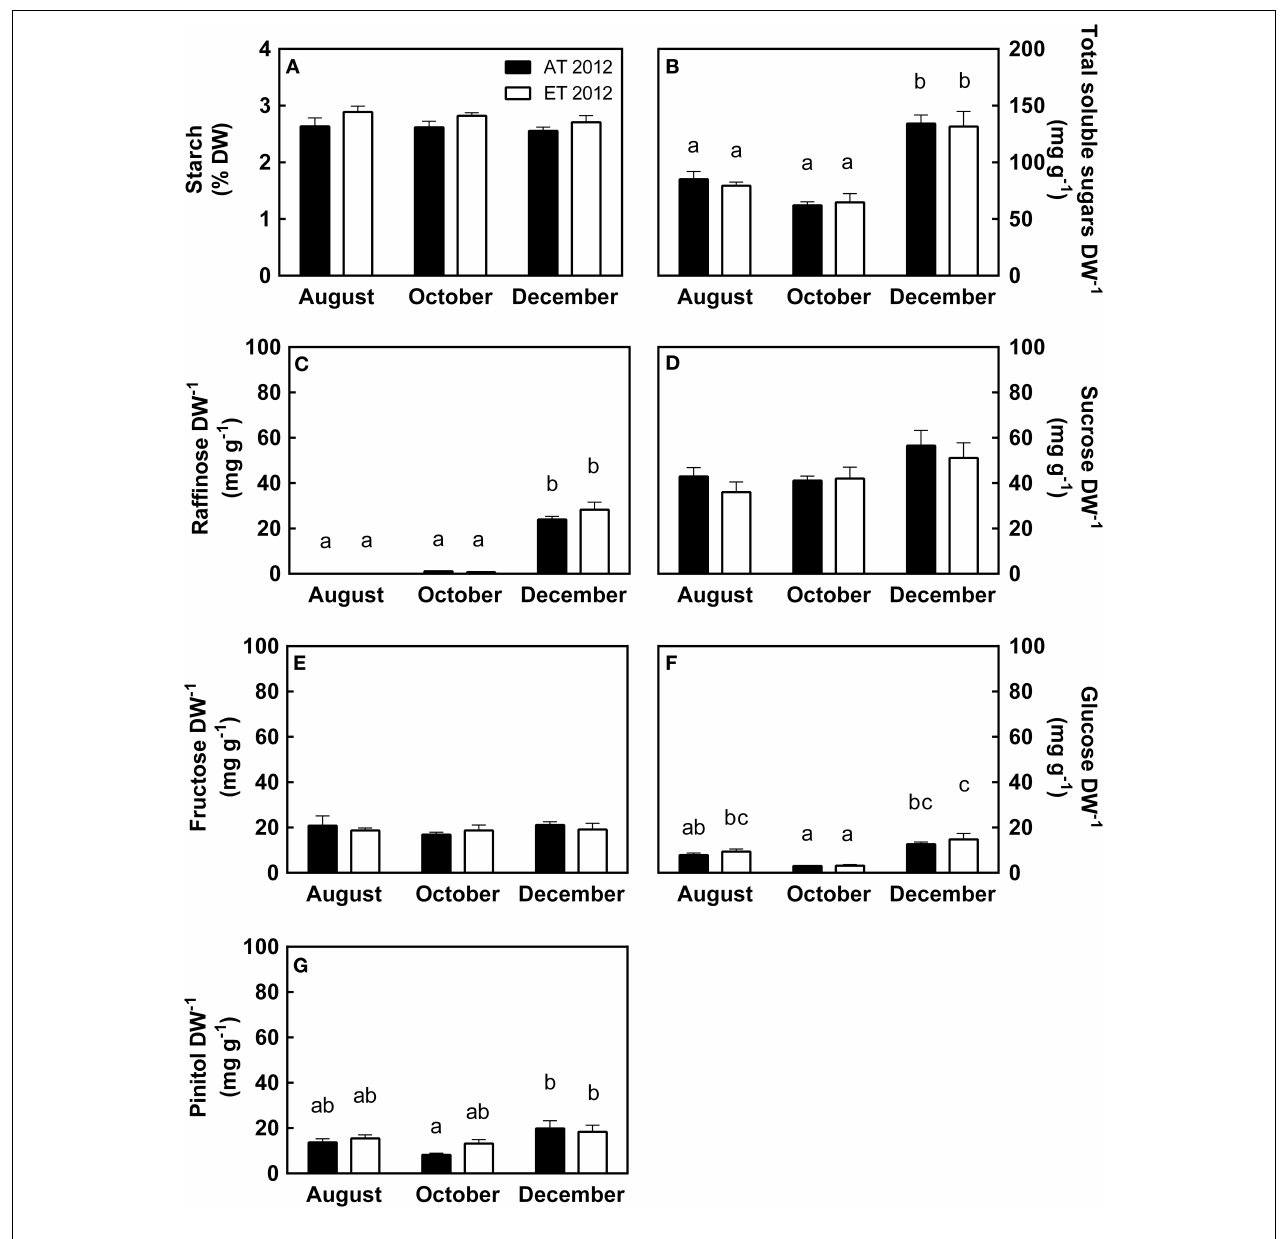
glucose content; (G) Leaf pinitol content, expressed per unit dry weight. Samples were collected during August, October and December of 2012. AT and ET, seedlings grown at ambient and elevated temperature, respectively. Each bar represents the average of 5 plots, ± S.E. Letters, where present, indicate significantly different groups ( P < 0 . 05